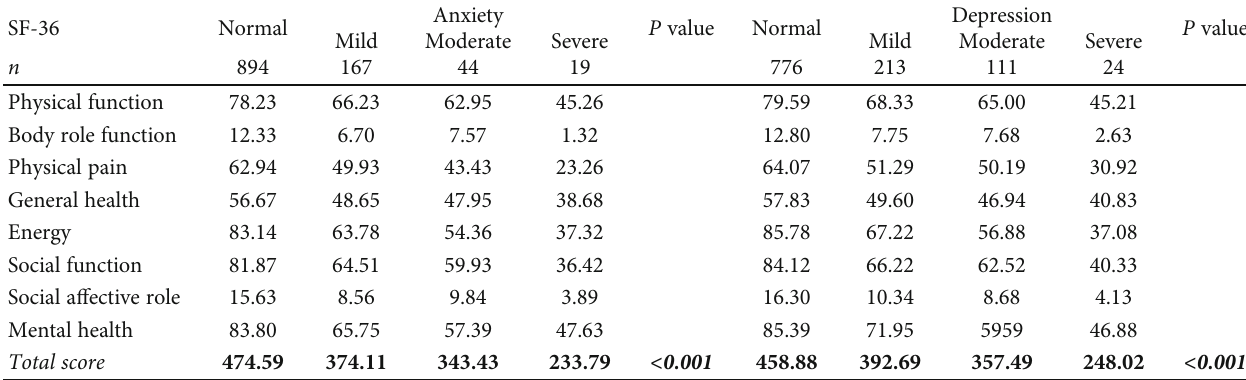
Table 6: SF-36 scores in di ff erent degrees of anxiety and depression.